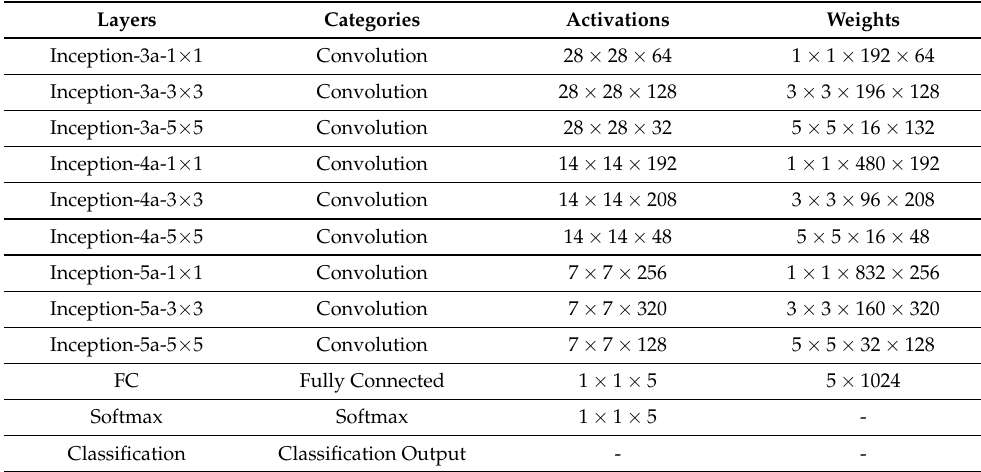
Table 3. GoogLeNet network used for guava disease detection.